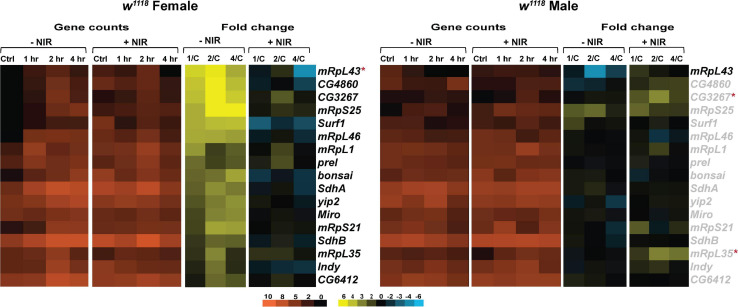
NIR exposure downregulates mitochondrial gene transcription in w1118 flies subjected to TBI. Heatmaps depicting mitochondrial gene expression changes in w1118 females and males at control, 1, 2, and 4 hr after injury and NIR exposure. The orange scale represents average normalized counts for three replicates in each of the indicated groups. Yellow-blue scale shows fold change for each gene at 1-, 2-, and 4-hr post-injury compared to control. The genes indicated in black font are significantly changed in injured flies not exposed to NIR whereas red asterisk (*) indicates significant alteration in injured flies exposed to NIR (| log2FC| > 1, p-value < 0.05). 1/C: Fold change at 1 hr compared to control; 2/C: Fold change at 2 hr compared to control and 4/C: Fold change at 4 hr compared to control. (–NIR: not exposed to NIR and +NIR: exposed to NIR).